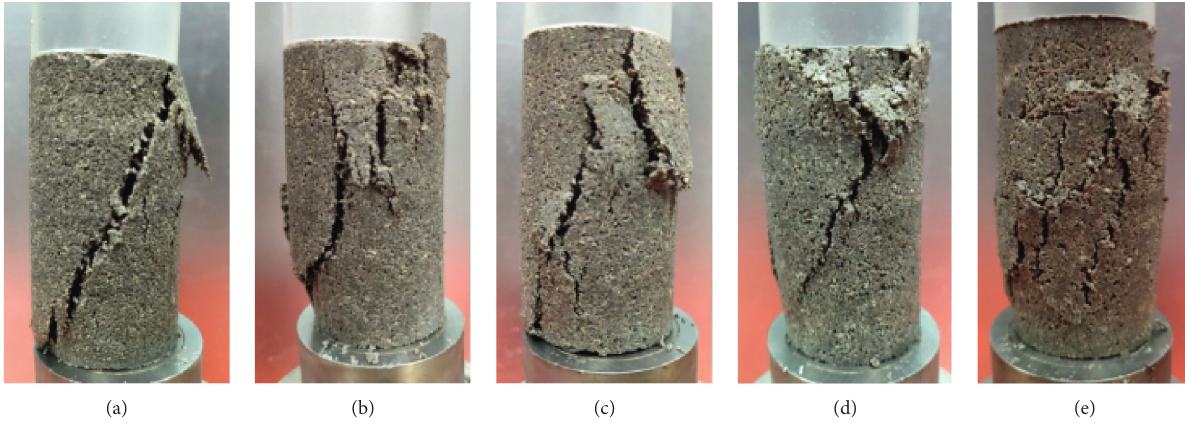
Figure 13: The destroying forms of CCS and NCCS on 28d. (a) CCS. (b) NCCS-4. (c) NCCS-6. (d) NCCS-8. (e)